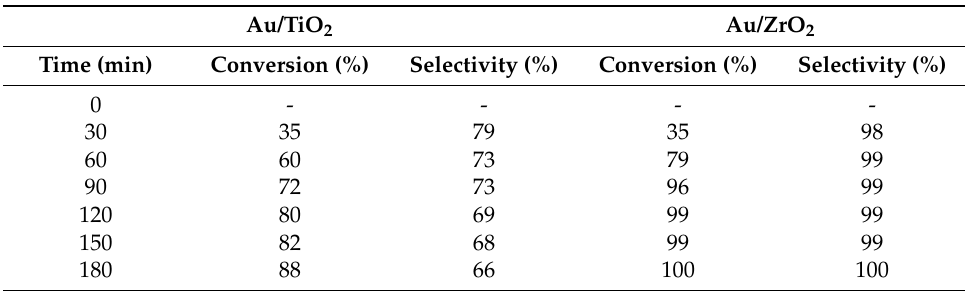
Table 3. Comparison between the catalytic performances at increasing time of reaction of Au/TiO 2 and Au/ZrO 2 . Au/TiO